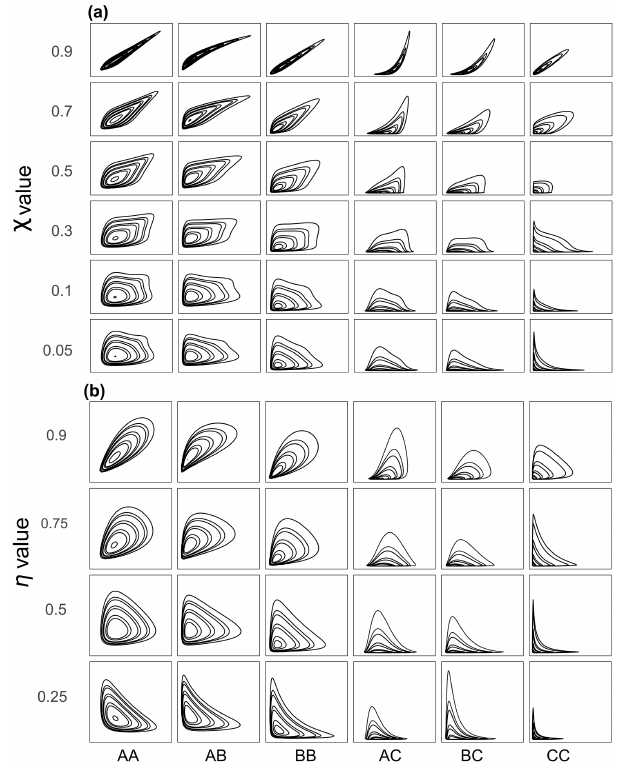
Figure 5. The 60 different synthetic bivariate datasets used in our simulation study. On the y axis: the dependence strengths (a) χ (for asymptotic dependence) and (b) η (for asymptotic independence) vary from slightly negative association to heavily dependent (see also Fig. 2). On the x axis AA to CC represent the marginal distri- butions that are part of the bivariate distributions (see Table 3) with A, B and C representing log-normal distributions with different co- efficient of variations c v (A: c v = 0 . 25; B: c v = 0 . 47; C: c v = 0 . 95).